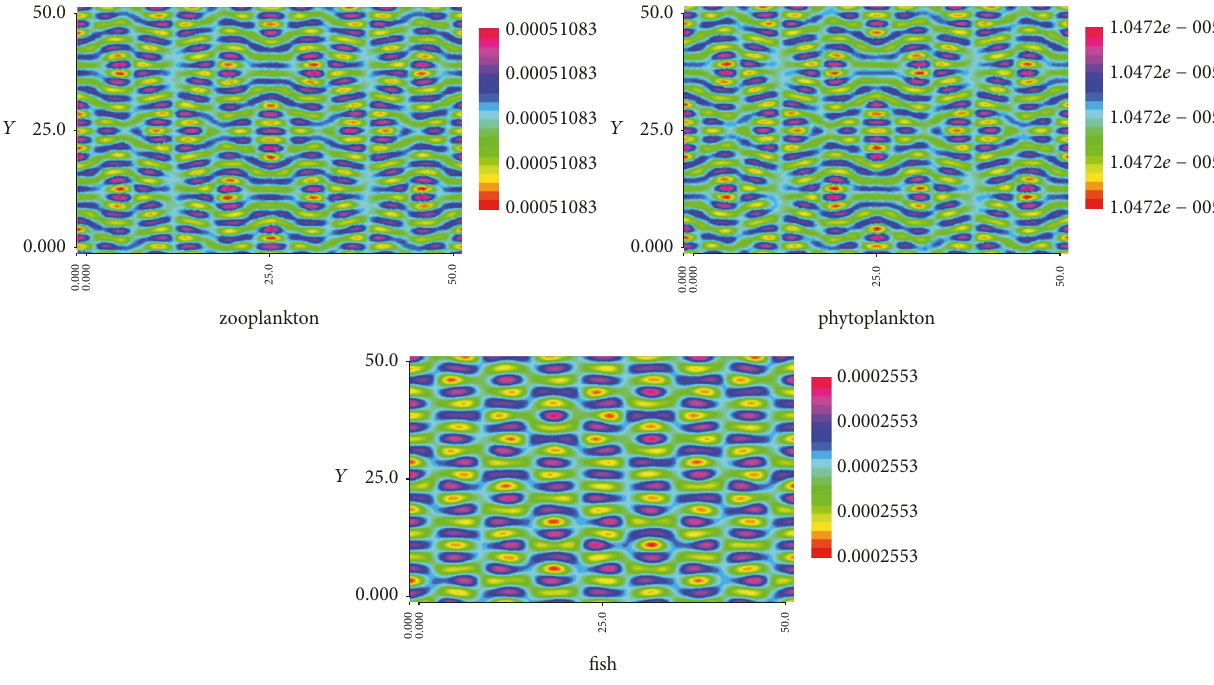
Figure 6: Spatial distribution of the system with 𝑏 0 = 0.61 and 𝛼 0 = 0.69 .